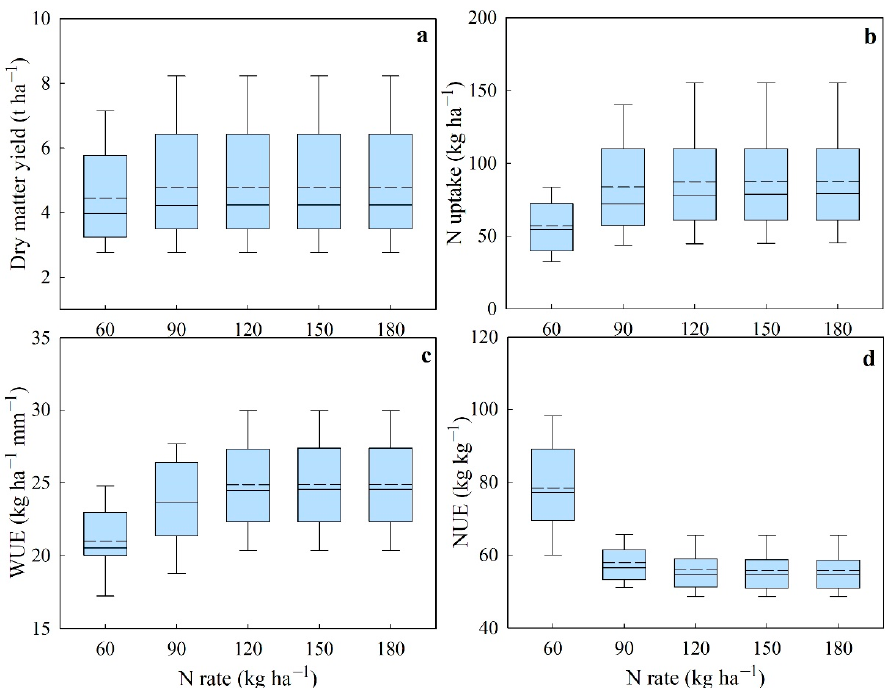
Figure 8. The 30-year average dry matter yield ( a ), N uptake ( b ), WUE ( c ) and NUE ( d ) of oat as affected by N application under irrigated conditions on the Tibetan Plateau. The bottom and top edges of the box show the 25th and 75th quantiles, the solid line is the data median, and the dotted line is the data average.